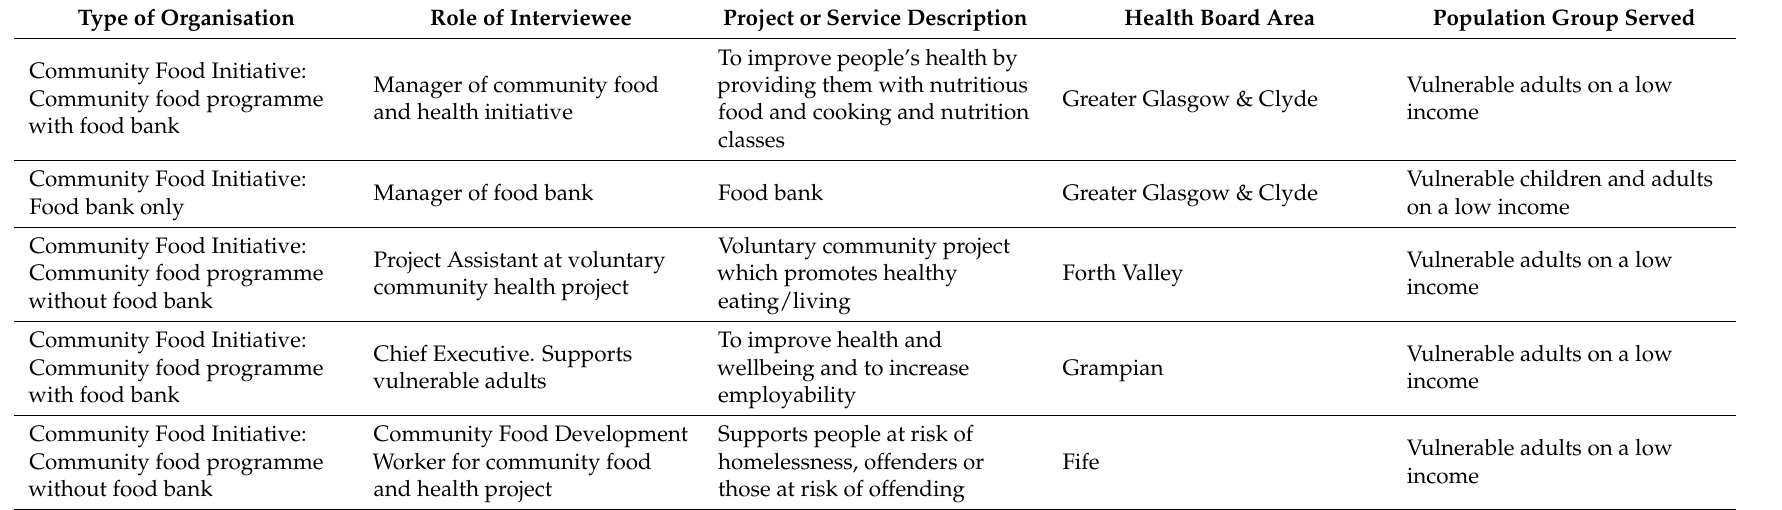
Table A2. Community Food Programme Informant